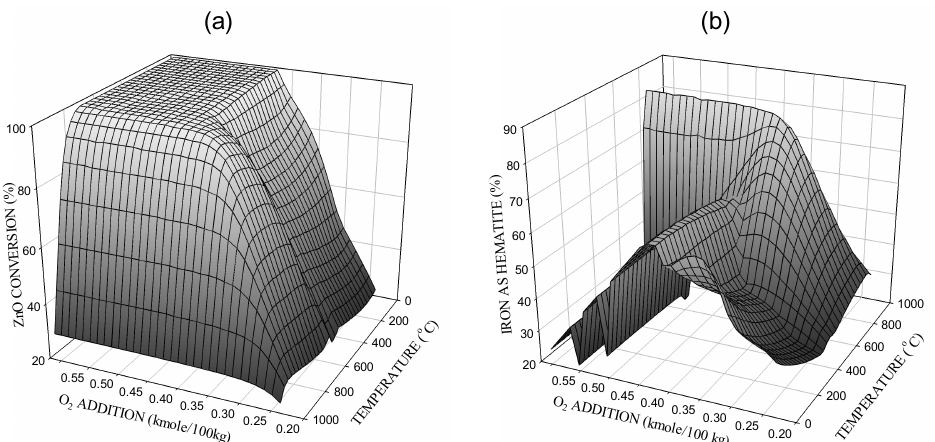
Figure 4. ( a ) Percent conversion of zinc oxide to zinc sulphate as a function of the oxygen addition and the temperature for a constant sulphur dioxide to oxygen molar ratio of two. ( b ) Percent retention of the iron as hematite as a function of the oxygen addition and the temperature for a constant sulphur dioxide to oxygen molar ratio of two.